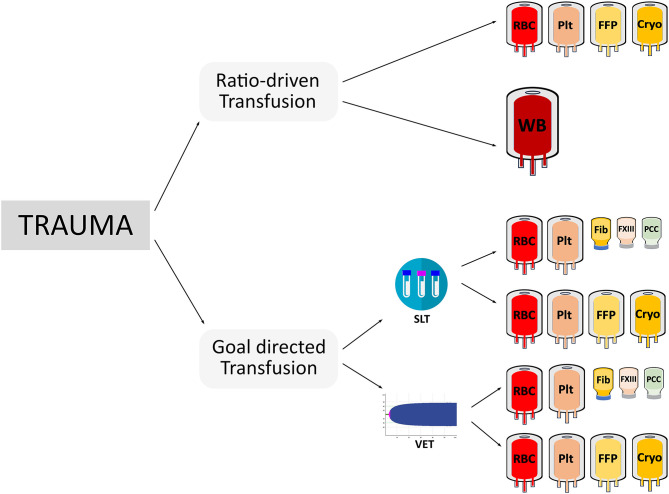
This figure illustrates the various potential treatment options for acutely bleeding trauma patients depicting the considerable differences in coagulation testing (SLT, standard laboratory testing; VET, viscoelastic testing), treatment options (ratio-driven vs. goal-directed transfusion), blood components (RBC, red blood cells; FFP, plasma; PLT, platelet concentrates; or CRYO, cryoprecipitate), the use of whole blood (WB), or coagulation factors (Fib, fibrinogen concentrate; PCC, prothrombin complex concentrate; FXIII, factor XIII concentrate).